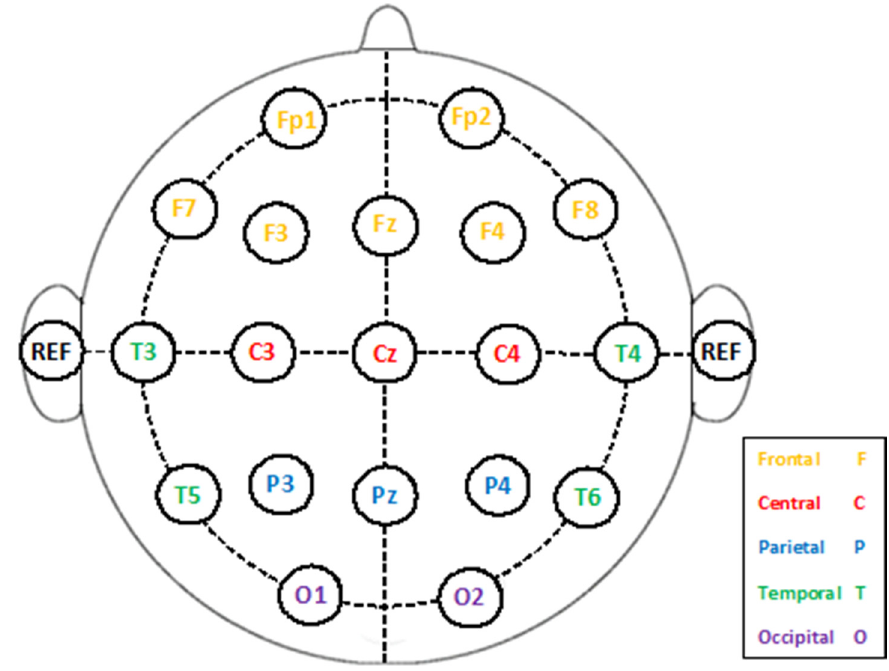
Figure 1. Electrodes placement on the scalp